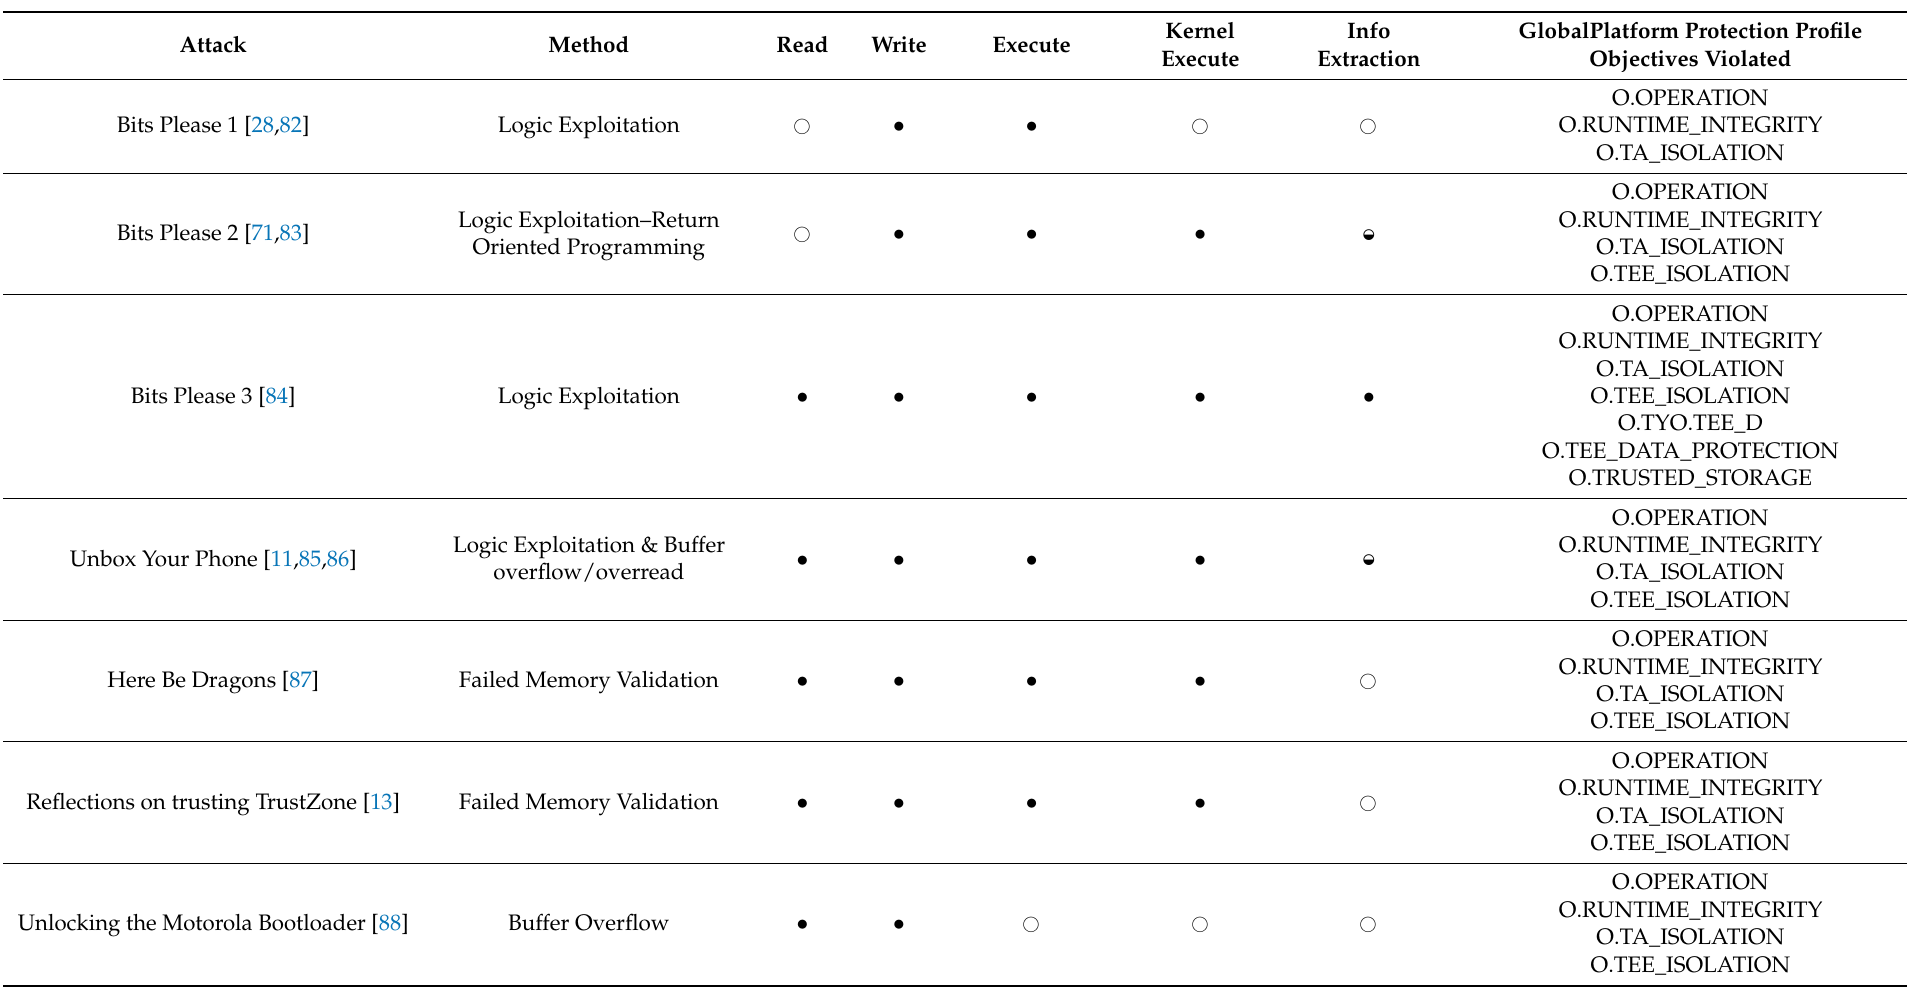
Table 2. A comparison of the analyzed attacks that showcases the methodology used, the primitives achieved, and the GlobalPlatform Protection Profile objectives violated by each attack. The Kernel Normal World (KNW) mark shows that the primitive targets the kernel of the normal world. ( ○ Not achieved ◒ Not achieved but trivial ● Achieved).